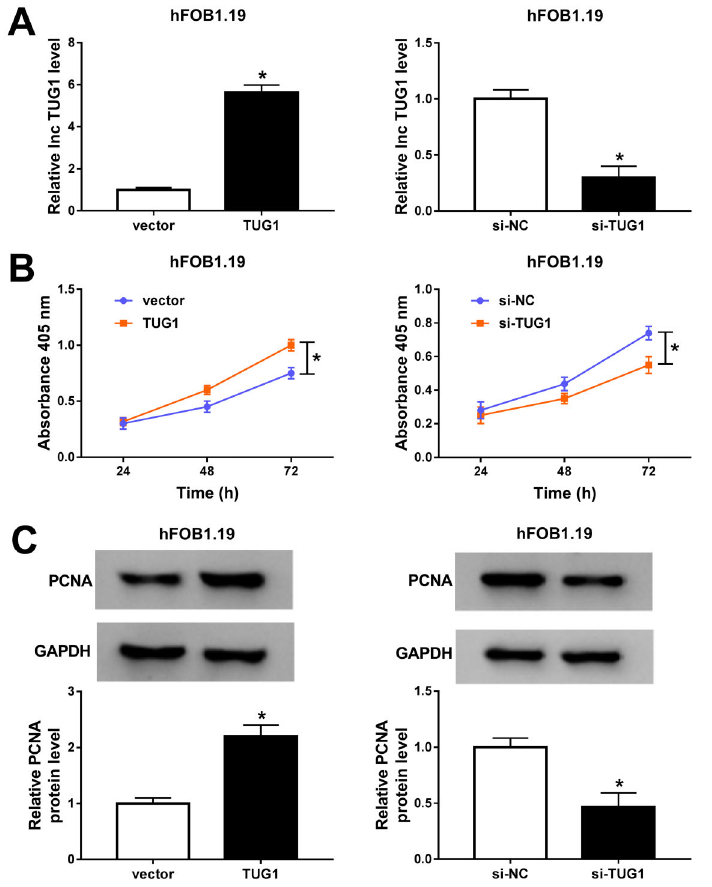
Figure 1. Long non-coding RNA TUG1 promoted hFOB1.19 cell proliferation. A – C , TUG1 was overexpressed or knocked down in hFOB1.19 cells after introduction of TUG1 or si-TUG1. A , The expression of TUG1 was determined by qRT-PCR. B , Cell viability was detected by CCK-8 assay. C , The expression of PCNA was measured by western blot assay. Data are reported as means ± SD of three independent experiments. *P o 0.05 (Student ’ s t -test).